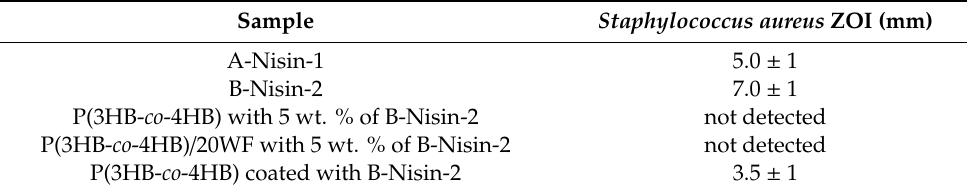
Table 6. Antimicrobial activity against Staphylococcus aureus (NCIMB 6571) using the disc diffusion assay.